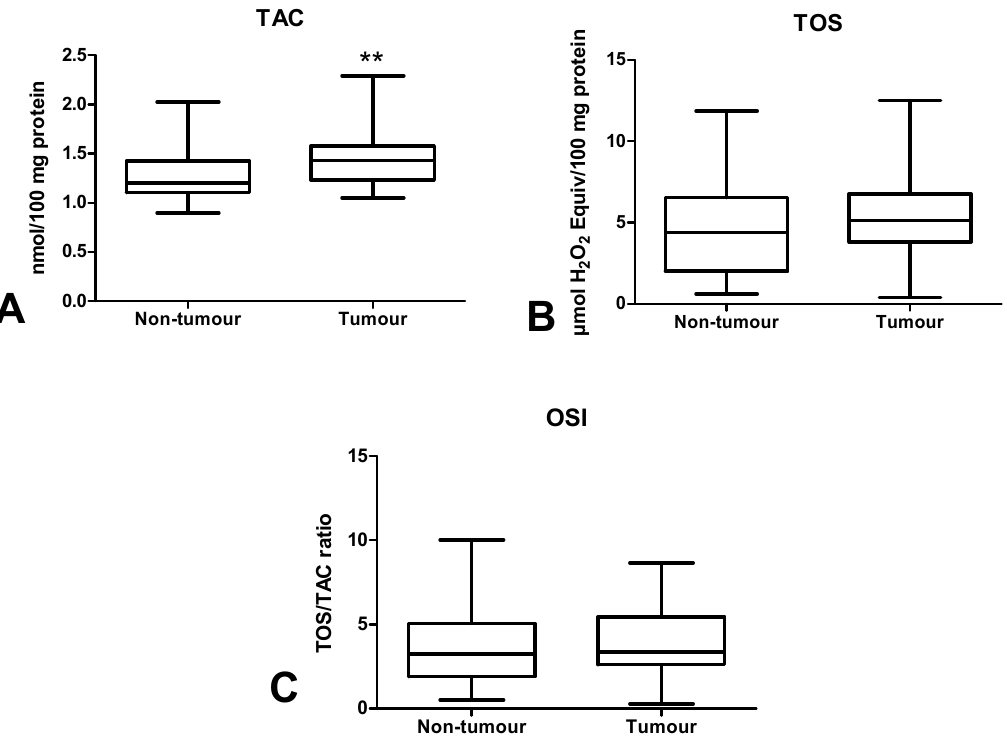
Figure 6. Comparison of TAC ( A ), TOS ( B ) and OSI value ( C ) between colorectal cancer tissue ( n = 29) and normal mucosa ( n = 29). The data are presented as median (minimum–maximum). Abbreviations: